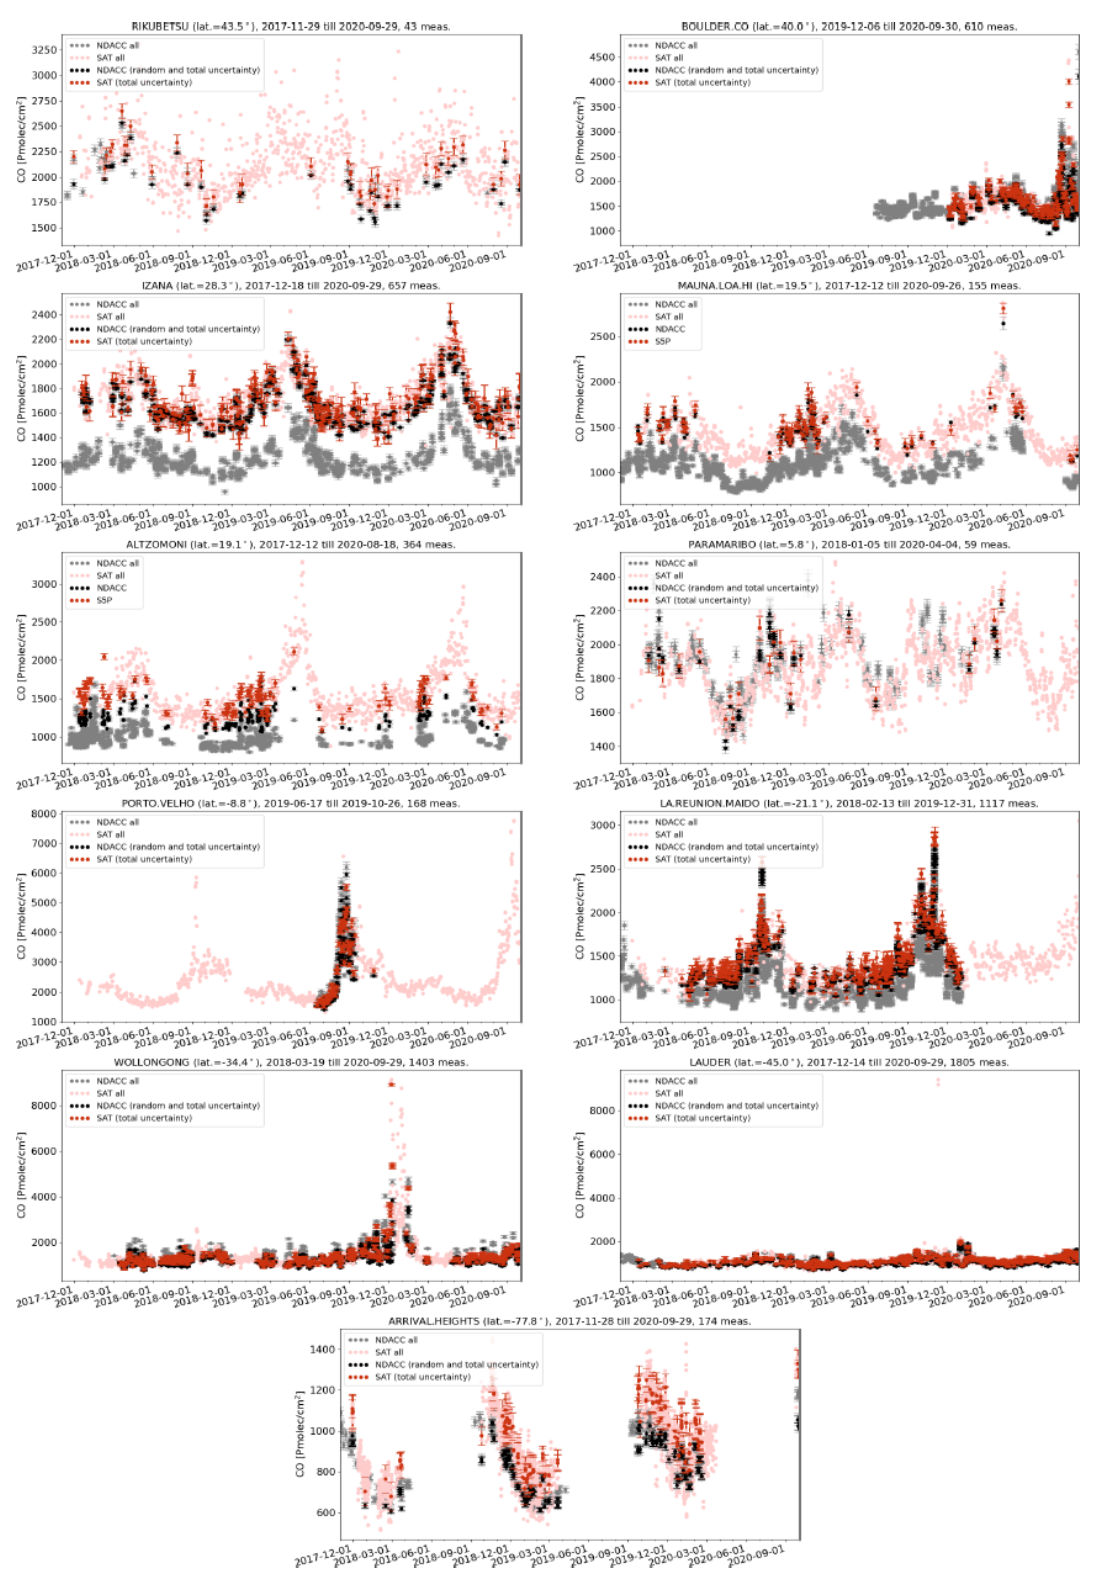
Figure 28. Same as Fig.